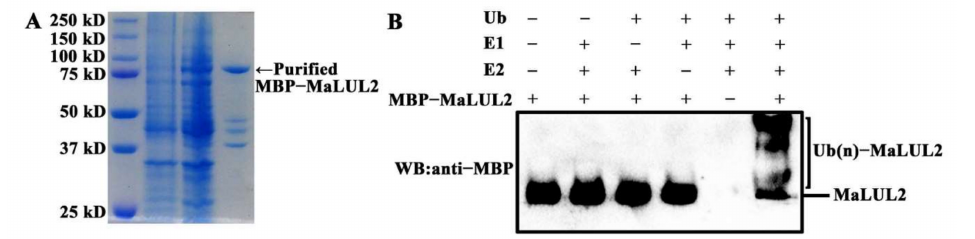
Figure 5. MaLUL2 protein exhibits E3 ubiquitin ligase activity. ( A ) The SDS-PAGE gel stained with Coomassie brilliant blue demonstrating a ffi nity purification of the recombinant MBP − MaLUL2 protein used for a ubiquitination assay. ( B ) The in vitro ubiquitination assay showing the E3 ubiquitin ligase activity of MaLUL2. Purified recombinant MBP − MaLUL2 protein was incubated with Ub, human E1, and human E2 UbcH5b at 30 ◦ C for 2 h. The reaction mixture was analyzed by immunoblotting with an anti − Maltose-Binding Protein (MBP) antibody. Ubiquitination results in a heterogeneous collection of higher molecular mass proteins that were detected using an anti − MBP antibody.